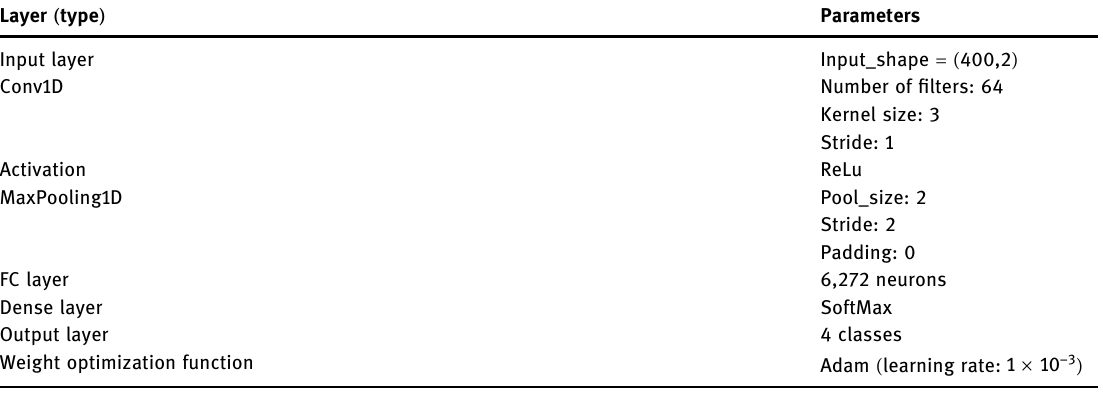
Table 2: Components of the proposed deep learning model and the various parameters adopted Layer ( type )